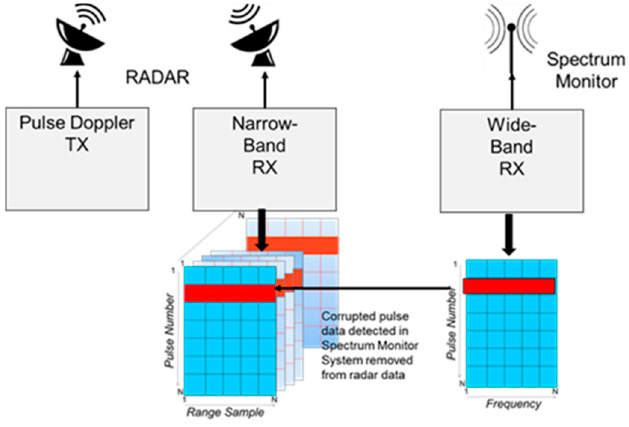
Figure 6. Wideband detection of impulse events with feedback to narrow-band target detection.